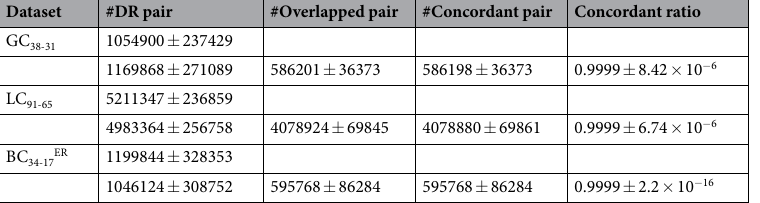
Table 2. Mean and standard deviation of the number of DR gene pairs identified from random subsets.